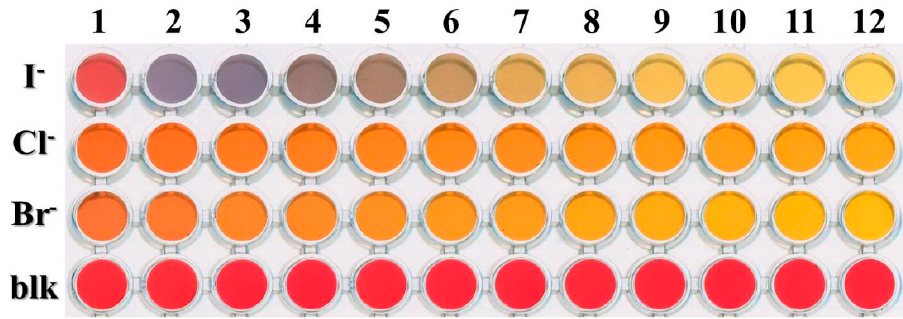
Figure 7. Example of calibration set employed for determination of chloride (26.5; 30.1; 37.0; 40.4; 45.4; 50.4; 53.6; 61.4; 69.0; 76.3; 83.3 and 90.2 mM); bromide (1.33; 1.50; 1.85; 2.02; 2.27; 2.52; 2.68; 3.07; 3.45; 3.81; 4.17 and 4.51 mM) and iodide (0.23; 0.27; 0.30; 0.37; 0.40; 0.45; 0.50; 0.54; 0.61; 0.69; 0.76 and 0.83 mM). The blk means blank which is given for comparison.